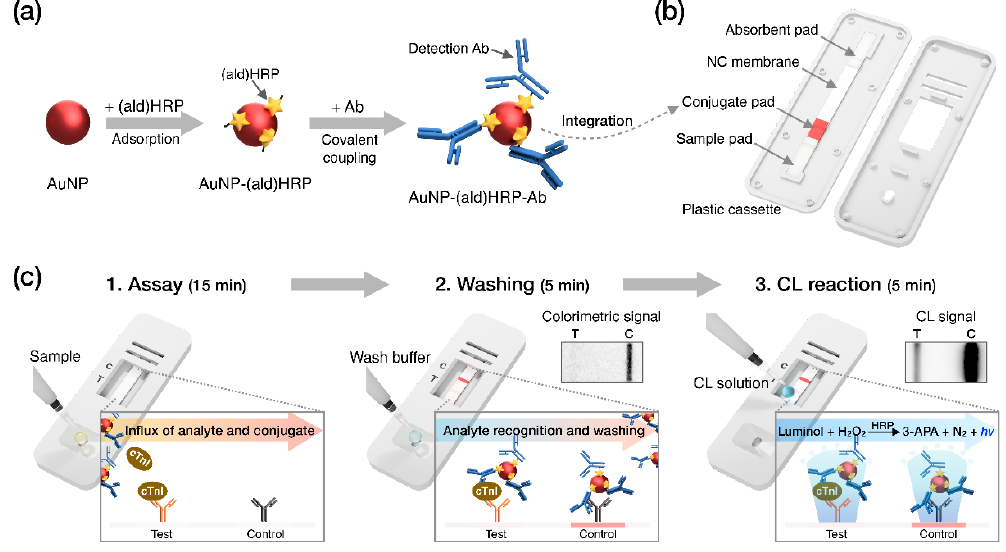
Figure 1. Schematic overview of this study. ( a ) Procedure used to prepare the gold nanoparticle–aldehyde-activated horseradish peroxidase–Ab (AuNP-(ald)HRP-Ab) conjugate. ( b ) Diagram of the lateral flow assay (LFA) test strip. ( c ) Operational process and reactions during the indicated steps. “ hv ” indicates light generated from chemiluminescence (CL) reaction.